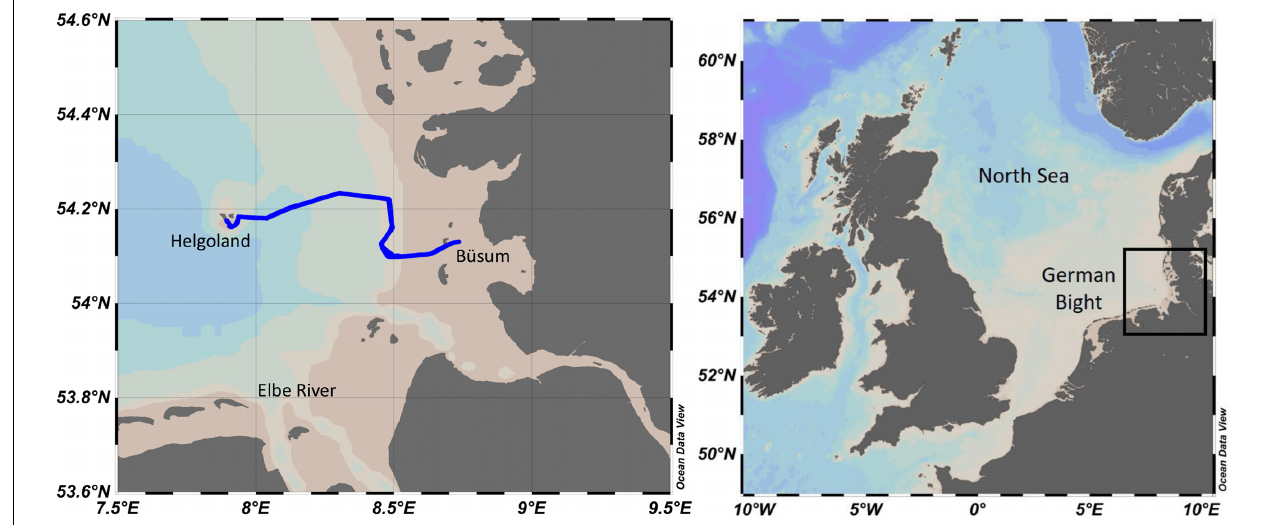
FIGURE 4 | Left panel: map showing the expedition track of the RV Littorina during the Sternfahrt-1 in the southeastern North Sea, from Büsum to Helgoland. Right panel: North Sea and location of the German Bight.